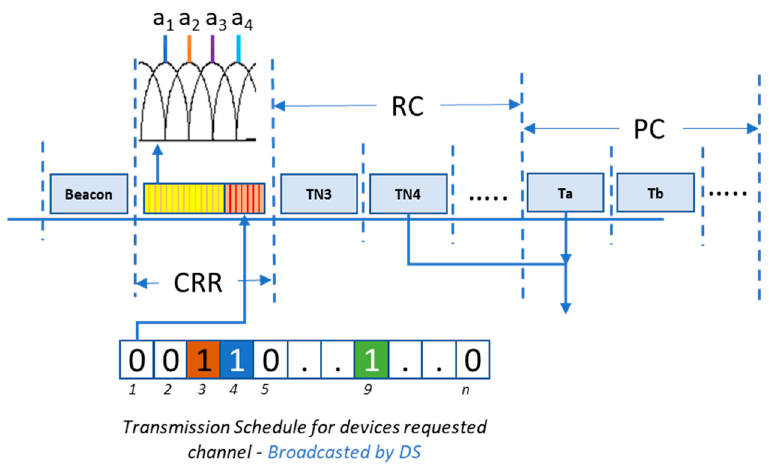
Figure 2. Super-frame structure.